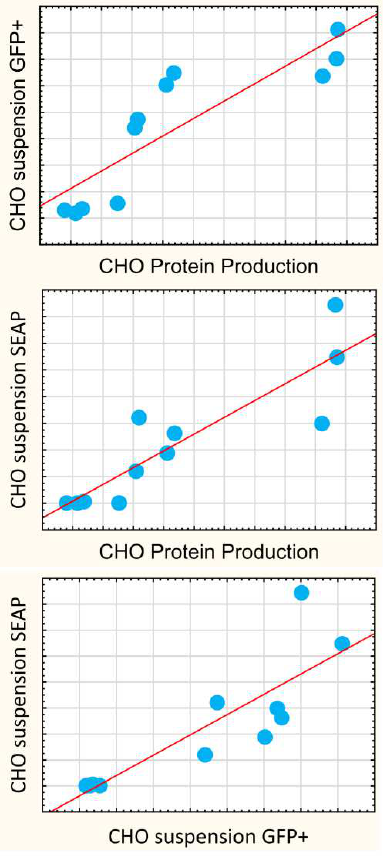
Figure 5. The protein production yield correlates with short-term assays of the secreted reporter protein and transfection positive population in CHO suspension culture. A scatterplot that highlights the correlations between the protein production yields and the assays of transfection-positive cell population (r = 0.86, p < 0.05) and SEAP protein secretion (r = 0.88, p < 0.05) in CHO suspension cells. The full correlation matrix with the Pearson coefficients is presented in Supplementary Table S3.